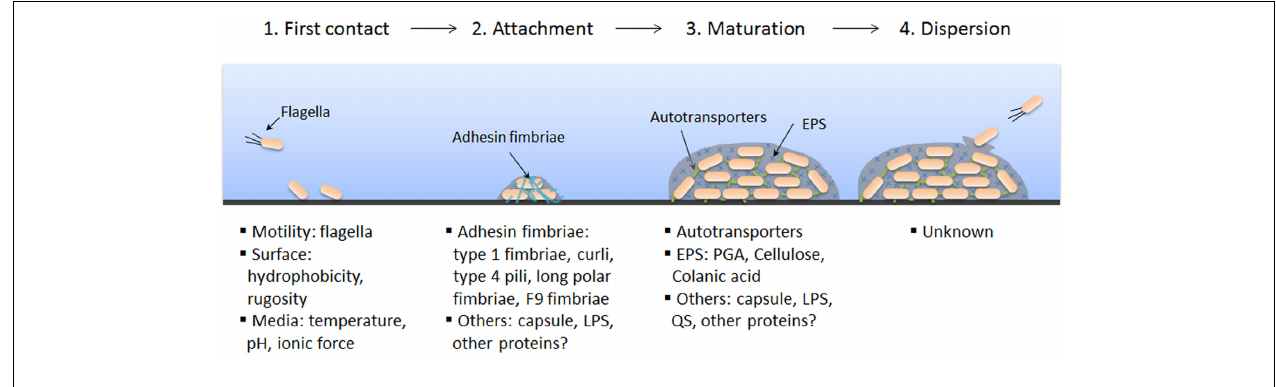
FIGURE 1 | Schematic representation of biofilm formation and STEC factors associated with each step. Biofilm formation is a dynamic and complex process influenced by several bacterial and/or environmental factors. Biofilm formation occurs in four steps: first contact, attachment, maturation, and dispersion. Factors that are known to play a role in STEC